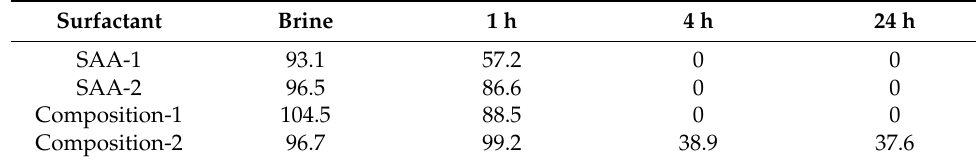
Table 6. Measurement of the contact angle for Bashkirian stage. Surfactant